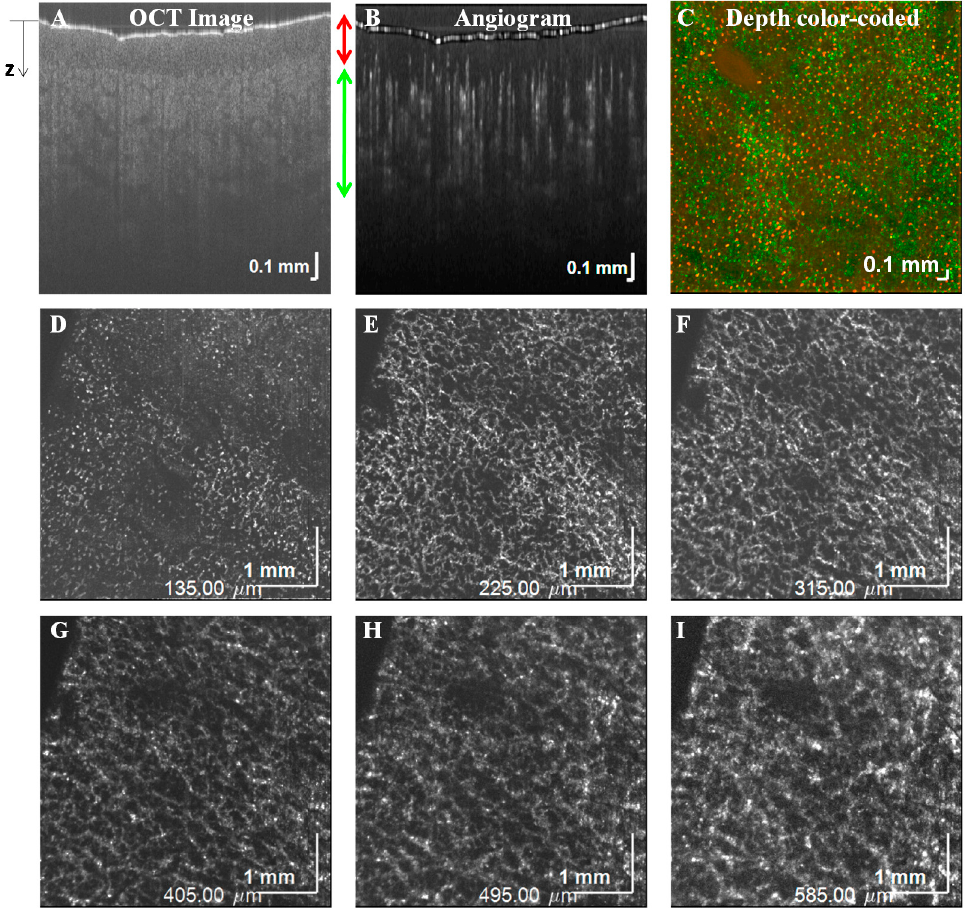
Figure 9. OCTA of the skin on a pig ear. OCT cross-sectional intensity image ( A ) and angiogram ( B ) determined by complex subtraction. ( C ) Overlay of superficial vessels in the epidermis (red) with deeper vasculature in the dermis (green). ( D – I ) Maximum intensity projections centered at different axial (z) positions relative to the surface.